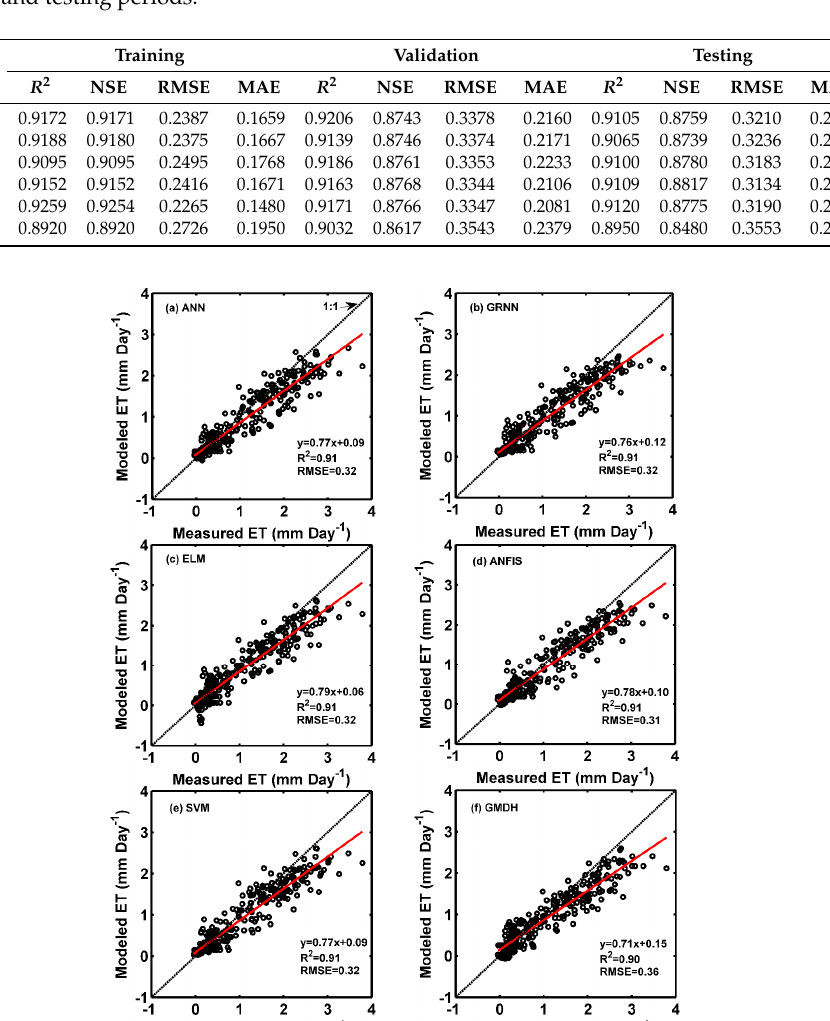
Figure 7. Comparisons of daily ET measured by eddy covariance technique and predicted by data-driven models for the testing period. ( a ) ANN model; ( b ) GRNN model; ( c ) ELM model; ( d ) ANFIS model; ( e ) SVM model; and ( f ) GMDH model.